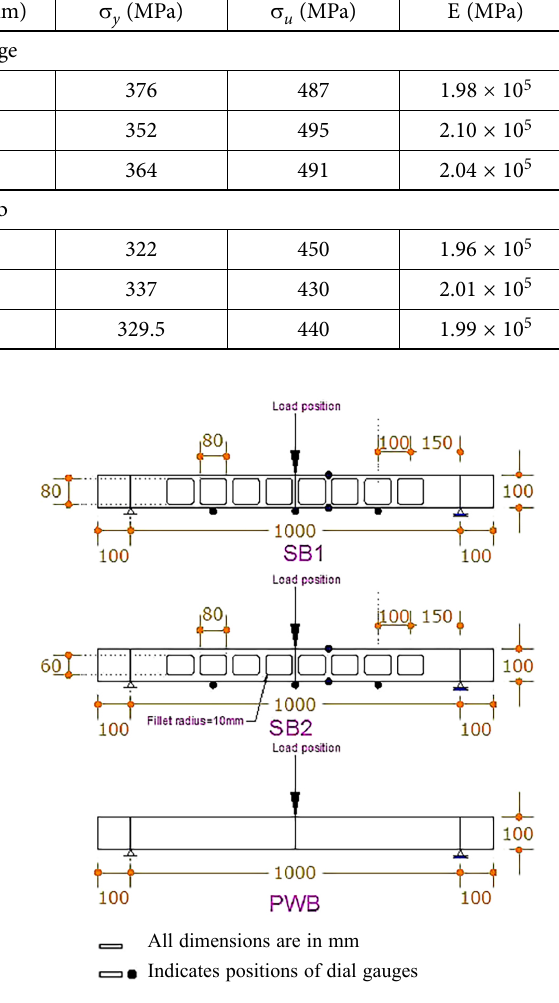
Fig. 2. Typical view of the coupon test Fig. 3. Details of the test beam